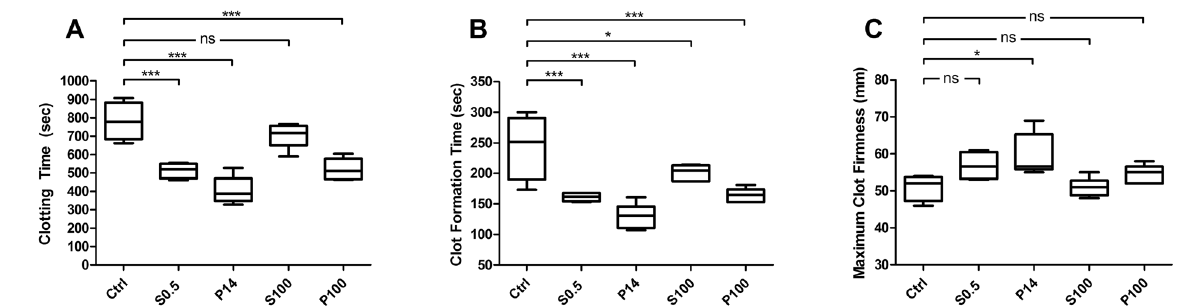
Figure 4. Influence of stimulated EC culture supernatants and concentrated pellets on ROTEM. Different fractions of the supernatants from ECs stimulated with TNF- α for 24 h were collected and 50 µ l study samples were added to 300 µ l fresh whole blood and subjected to ROTEM analysis. Ctrl = control (phosphate buffered saline); S0.5 = cell free culture supernatant; P14 = pellet containing larger EVs; P100 = pellet containing smaller EVs; S100 = vesicle free supernatant, Box-and-whisker plots (min, max, 25th–75th percentile, median); ns = not significant; * p < 0.05; *** p < 0.001. n = 4–6